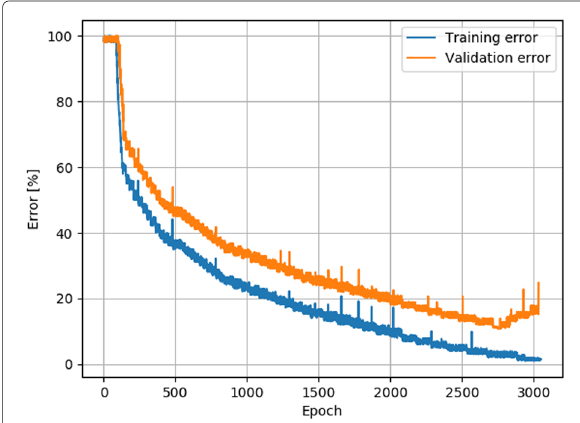
Fig. 4 Training process of warm-start approach. Error rate during the warm-start approach training